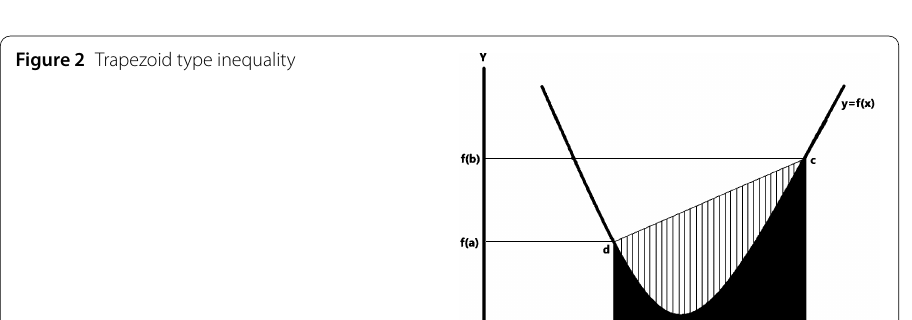
Figure 2 Trapezoid type